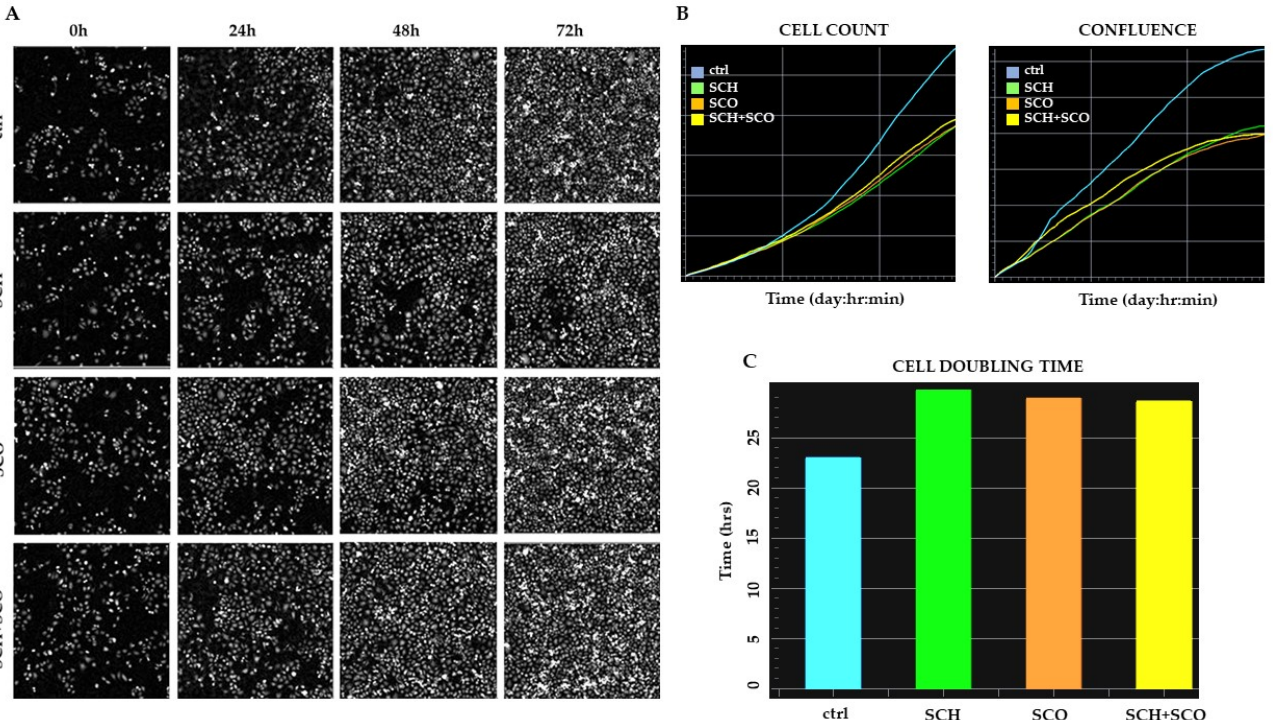
Figure 5. Quantitative phase imaging (QPI) and cell proliferation. ( A ) Representative image of QPI at 0, 24, 48, and 72 h of control and treated cells with 5 μ g/mL SCH or SCO , or co-administration of SCH and SCO 2.5 μ g/mL. ( B ) Plots of cell count and confluence over time for cells treated and untreated control. ( C ) Histogram plot illustrating median cell doubling time for cells treated and untreated control. Analysis of the growth curve was mediated on 6 wells for each treatment.